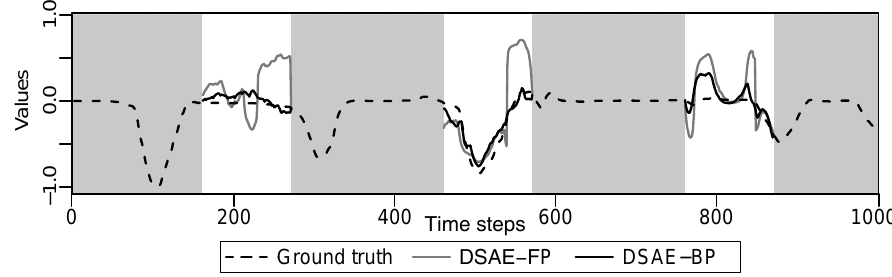
Figure 13. Example of defect repair of the steering angle by DSAE-FP and DSAE-BP for a part of C3 in the time-series, when the defect value was 1. A white background indicates the period of defects. The values in parentheses in the legend represent the defect